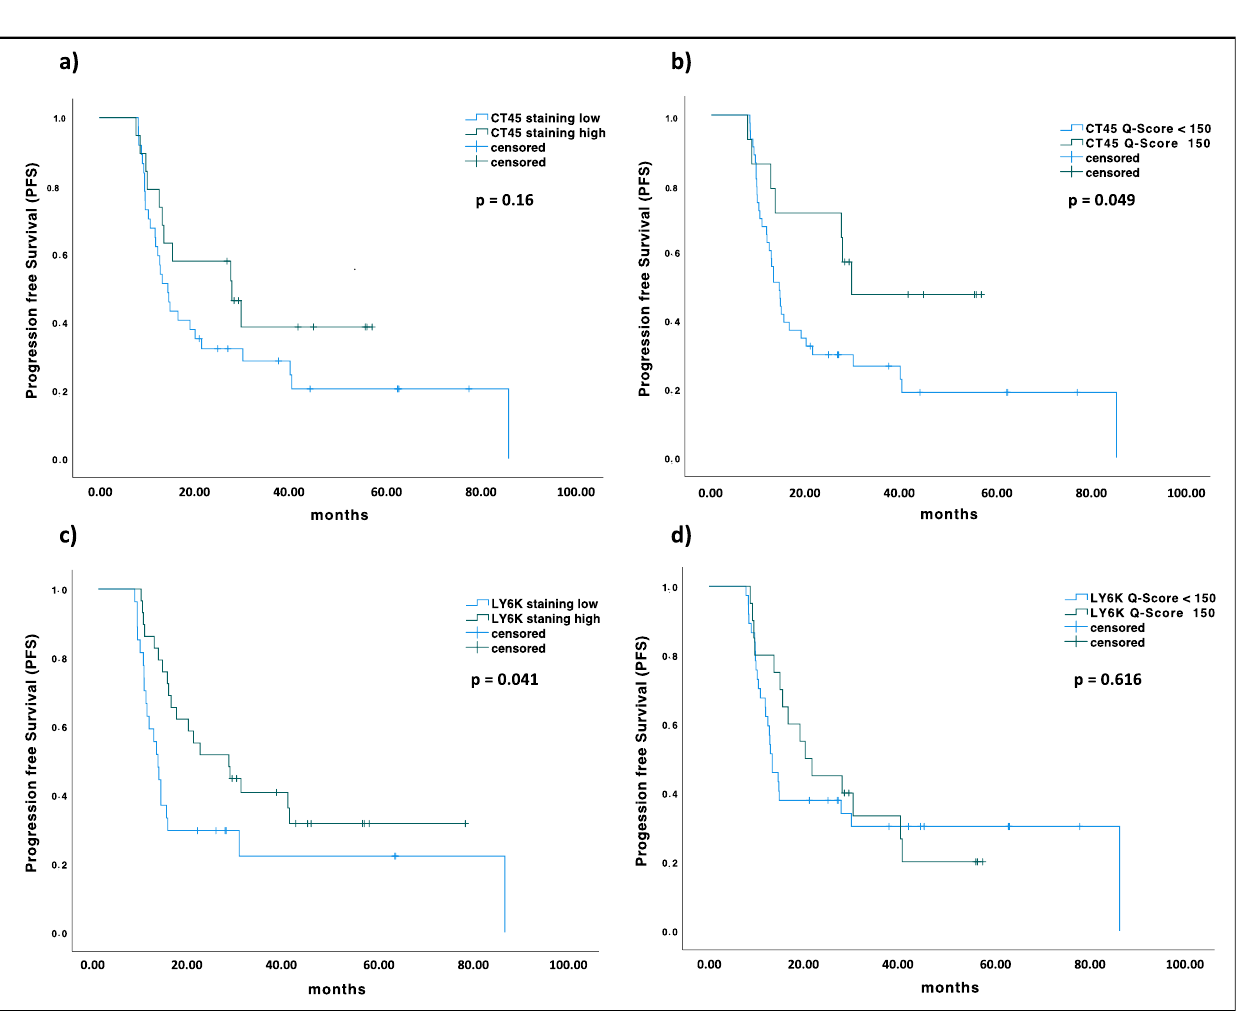
CT45 low (negative to weak staining) vs. green CT45 high (moderate to high staining), median PFS